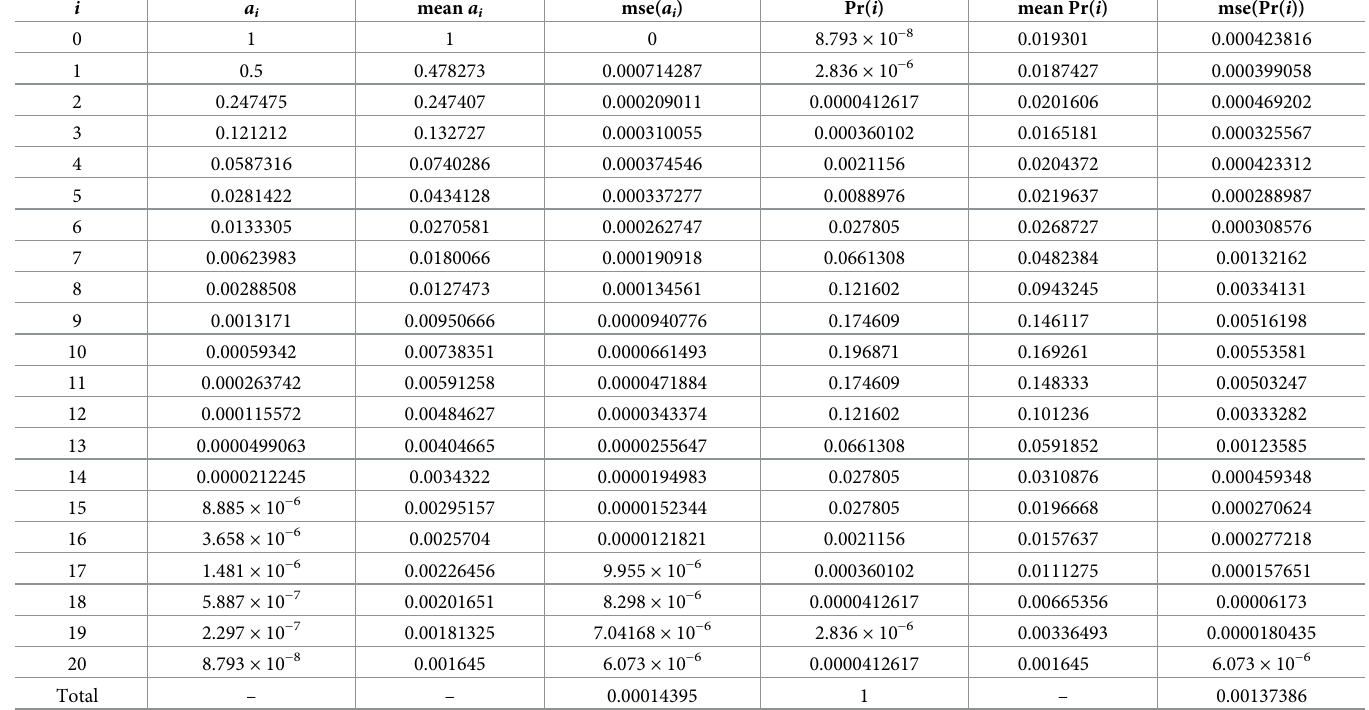
Table 5. Scenario 1. H (100, 50, n ) where n = 5, 10,